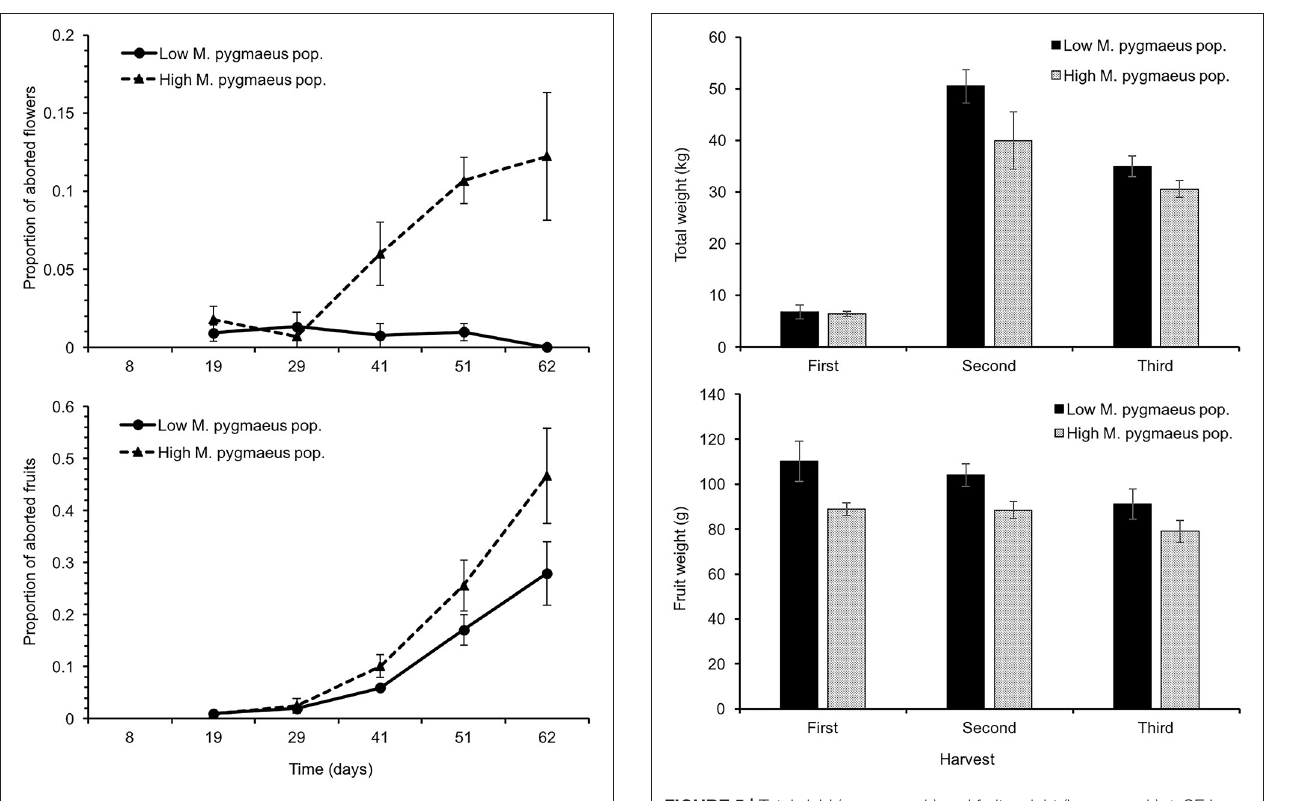
FIGURE 4 | Proportion of aborted flowers (upper graph) and fruits (lower graph) ± SE in tomato greenhouses with low and high M. pygmaeus populations. Time since the introduction of Bemisia tabaci .